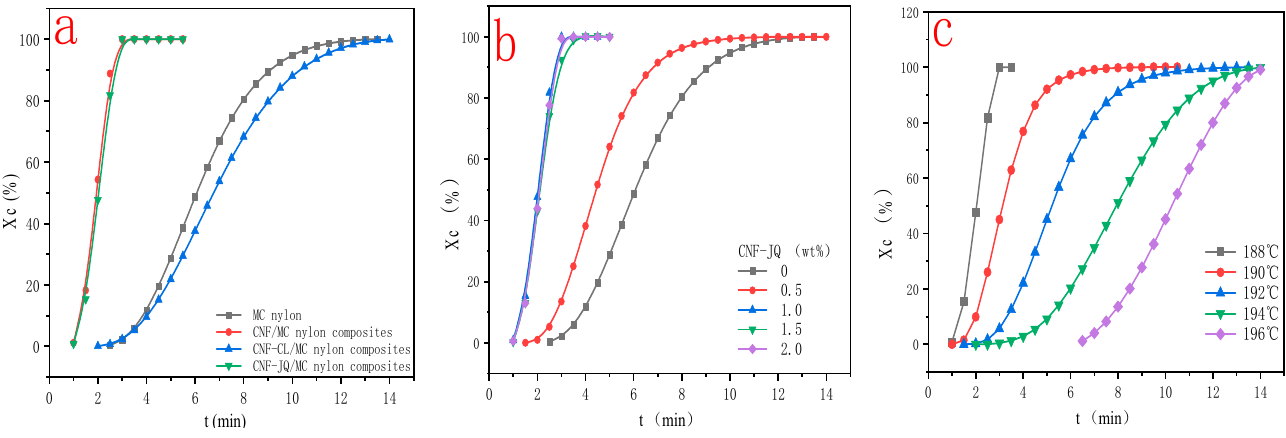
Figure 8. Relative crystallinity as a function of time for MC nylon and MC nylon composites (( a ) is the curve for different modified CNF at a cooling rate of 188 °C and filler of 1.0 wt%; ( b ) is the curve for different CNF–JQ additions when cooling down to 188 °C; ( c ) is the curve for different temperatures when CNF–JQ is 1.0 wt%).